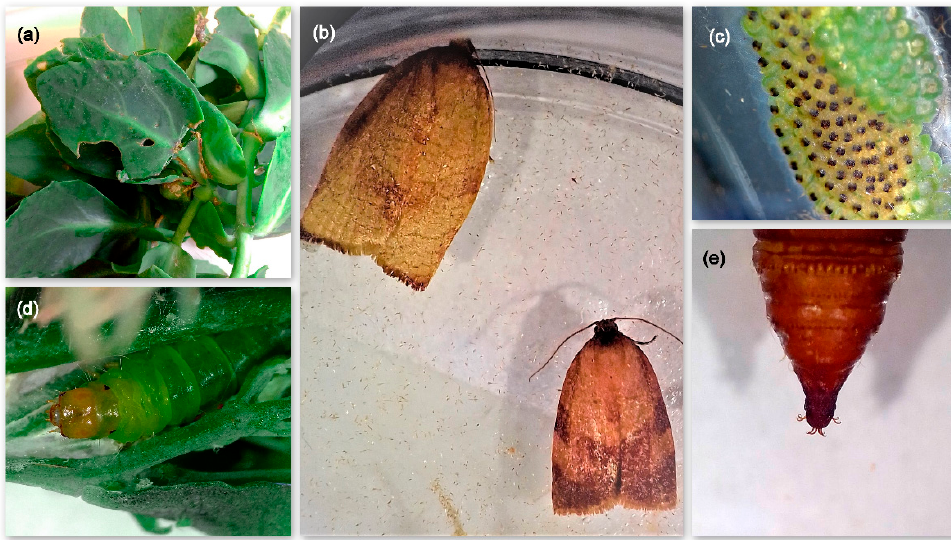
Figure 1. ( a ) Butterfly stonecrop plant leaves, chewed and knitted together by Cacoecimorpha pronubana larvae; ( b ) Female (left) and male (right) individuals of Cacoecimorpha pronubana ; ( c ) Eggs mass of Cacoecimorpha pronubana laid on petri-dish; ( d ) Cacoecimorpha pronubana larva on butterfly stonecrop plant inflorescence; ( e ) Cacoecimorpha pronubana pupa cremaster with 8 hooked bristles.